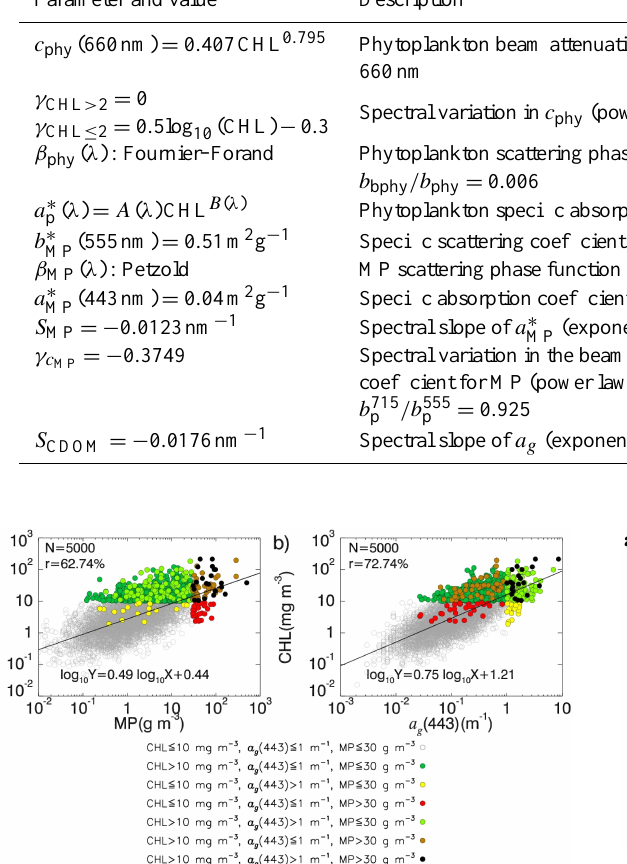
Figure 5. The simulated (a) MP and (b) a g (443) vs. the simu- lated CHL concentrations, in the CCRRv1. The colours represent the ranges of MP, CHL, and a g (443) as reported in the key above.